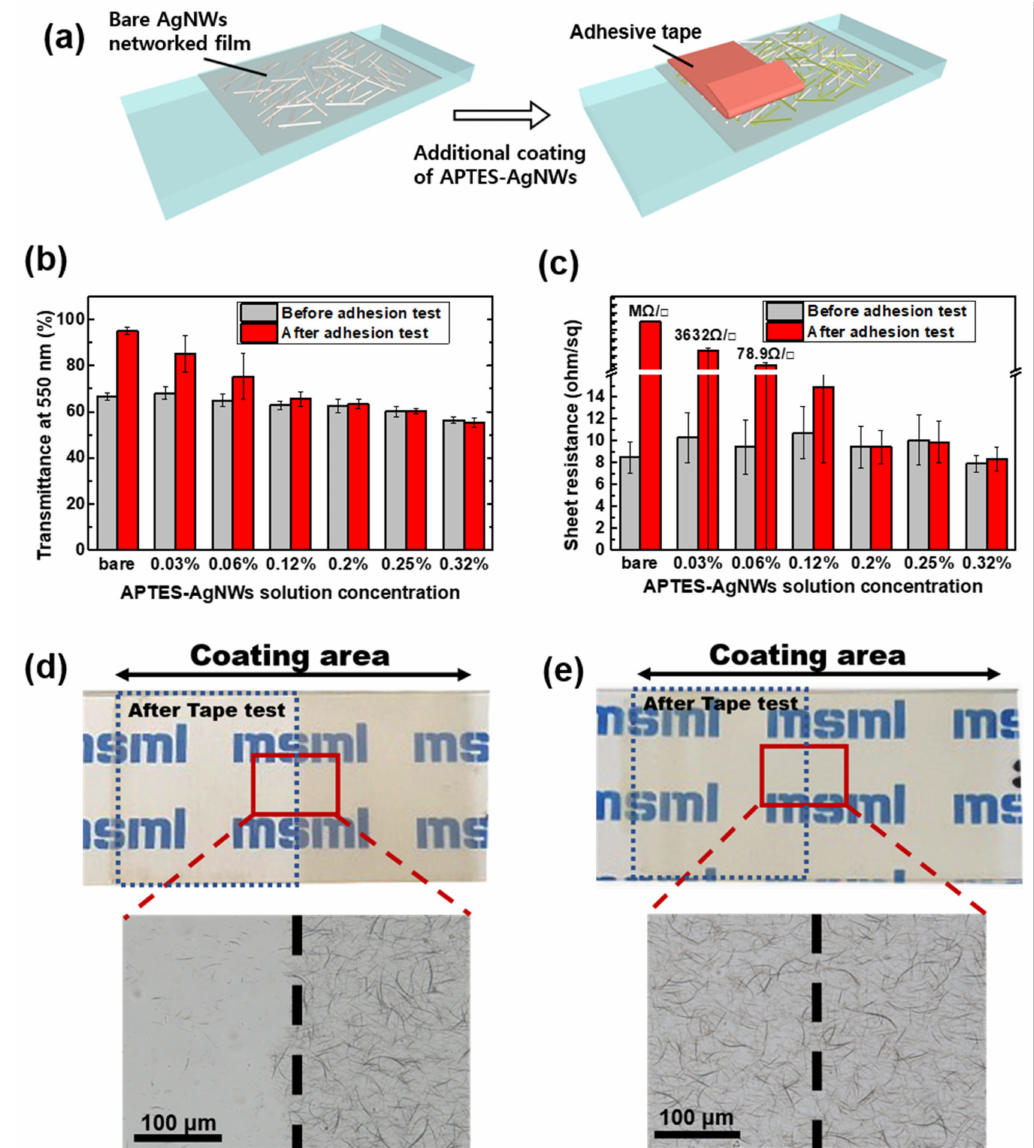
Figure 5. ( a ) Schematic of the preparation of the AgNWs thin films with the additional coating of the APTES-AgNWs and the tape test of the films. ( b ) Transmittance at λ = 550 nm and ( c ) sheet resistance of the AgNWs films with the APTES-AgNWs on a glass substrate as a function of the APTES-AgNW solution concentration (0.03, 0.06, 0.12, 0.2, 0.25, and 0.32 wt.%). Photographs (top) and OM images (bottom) of ( d ) the bare AgNWs film and ( e ) APTES-AgNWs/AgNWs composite film before and after the tape test. The bare AgNWs films were deposited directly on the glass substrate using 20 µ L of the 0.5 wt.% bare AgNWs suspension at DN = 3 and NC = 3. The APTES-AgNWs were deposited on the bare AgNWs film using 8 µ L of the APTES-AgNWs suspension at DN = 1 and NC =